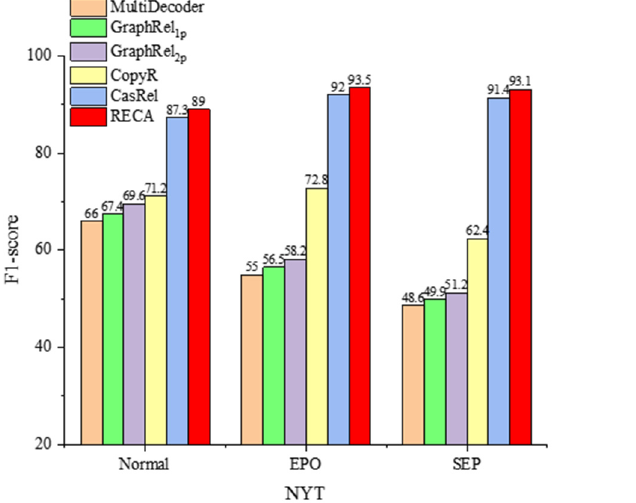
Table 3. Results for ablations experiments with the NYT and WebNLG datasets. The best scores are in bold font.